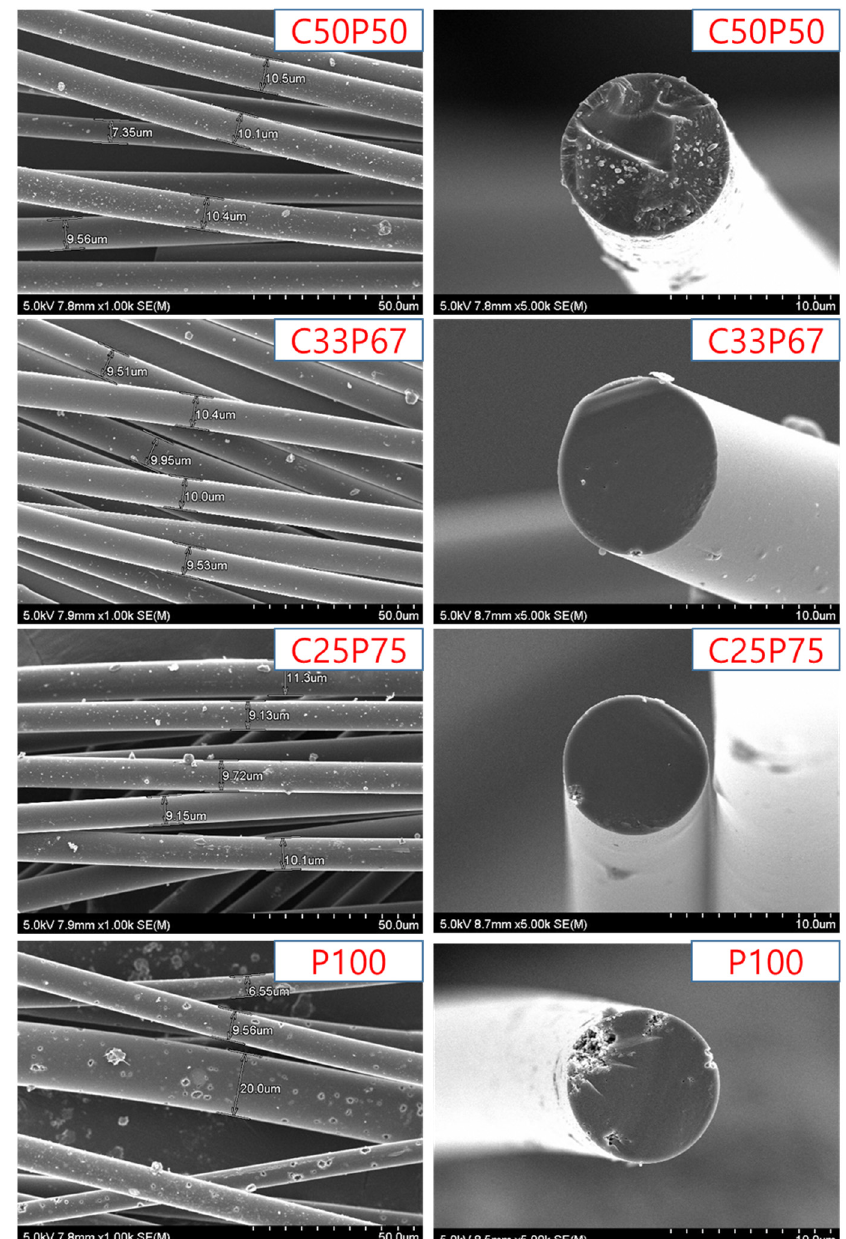
Figure 6. SEM analysis of isotropic carbon fibers prepared by co-carbonization of purified coal tar pitch and PFO in various ratios.